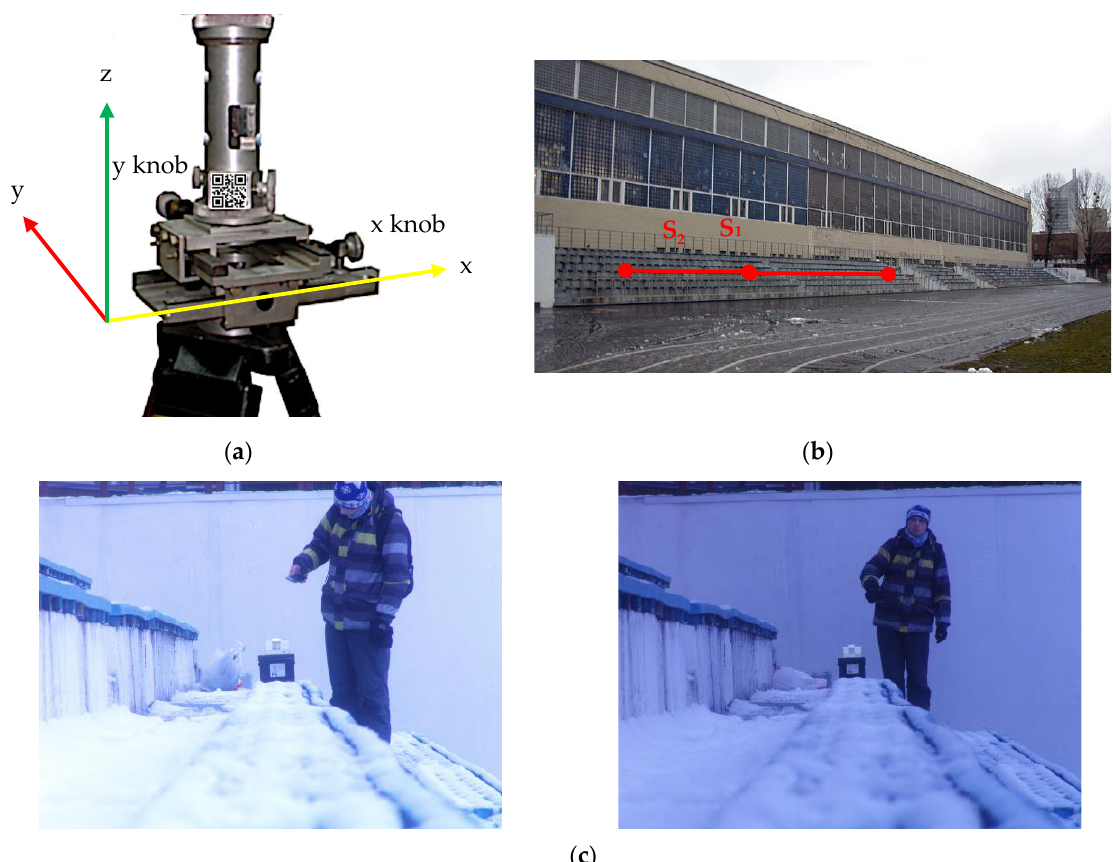
Figure 19. The equipment for the single-chain simulation: ( a ) mechanical equipment on a tripod for the precise displacement of QR target; ( b ) place for the test bench setup and single-chain test; ( c ) the sampling images from the testing site ( left image: ISO-800, right image: ISO-100).